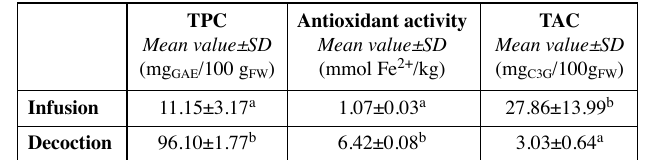
Tab. 3: Total polyphenolic content (TPC), antioxidant activity, and total an- thocyanin content (TAC) data in the analyzed plant extracts.